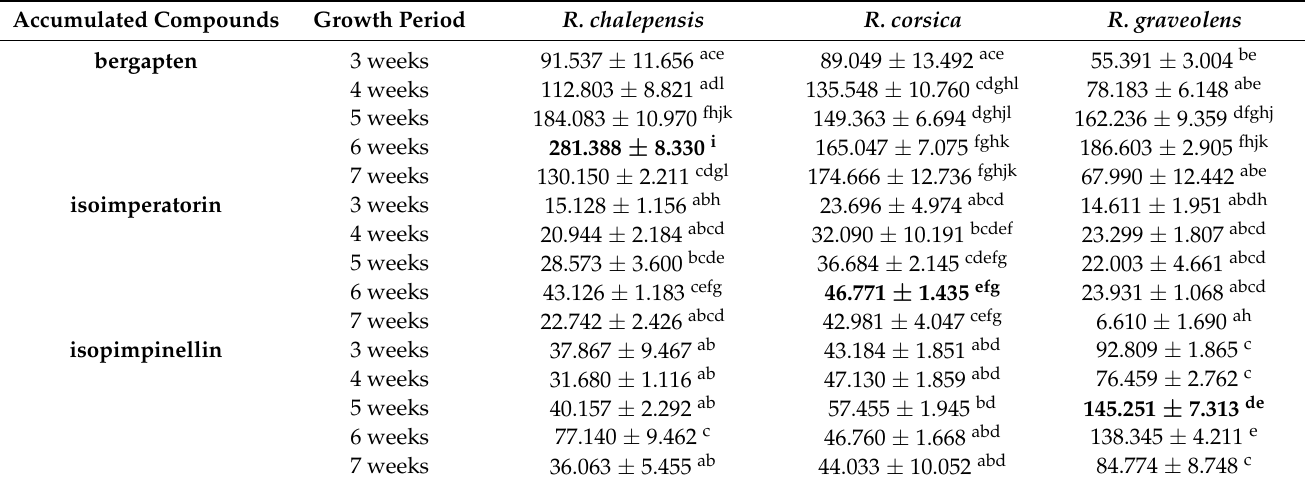
Table 1. Average contents of metabolites (mg/100 g DW) in methanol extracts obtained from biomass of cultures of three rue species depending on the duration of the culture (3, 4, 5, 6, and 7 weeks). Means of three measurements ± SD. Different letters indicate significant differences ( p <